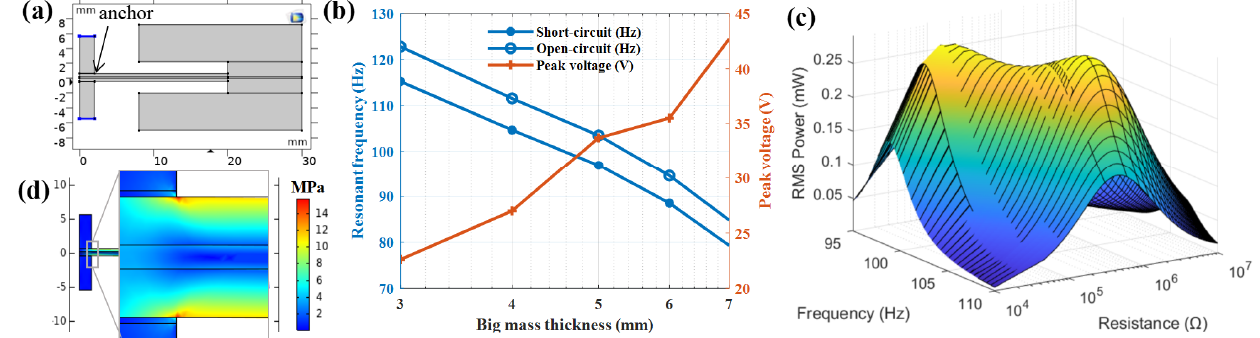
Figure 2. PVEH modeling and simulation: ( a ) PVEH 2D model; ( b ) PVEH resonant frequency and peak voltage varied with big mass thickness; ( c ) RMS power in different load resistance near resonant frequency of PVEH with 5 mm big mass thickness; ( d ) stress check cloud chart. Table 1. PVEH design parameters.